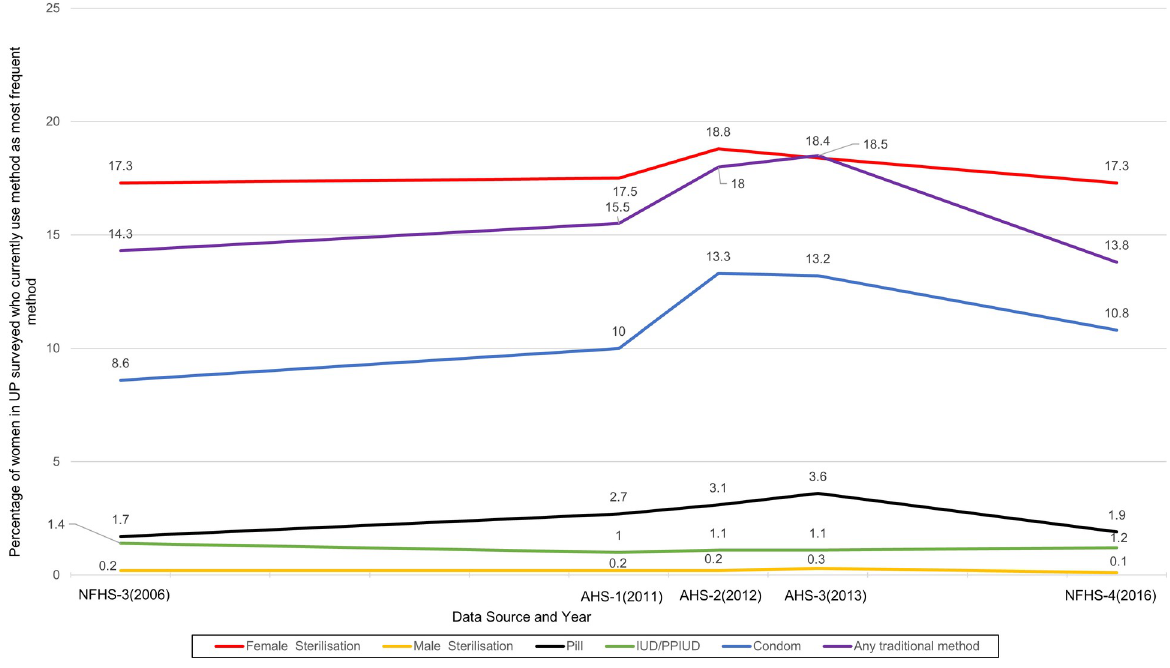
Fig 1. Little change in distribution of contraceptive use by method overtime in UP between 2006 and 2016. Figure shows combined analysis of responses in quantitative surveys described in methods (NFHS and AHS) to the question: “Which method are you currently using to delay pregnancy?”, considering the highest/most used method. Lactational amenorrhea method (LAM) has been deducted from the “Any traditional method” indicator in AHS to match the corresponding NFHS definition for this